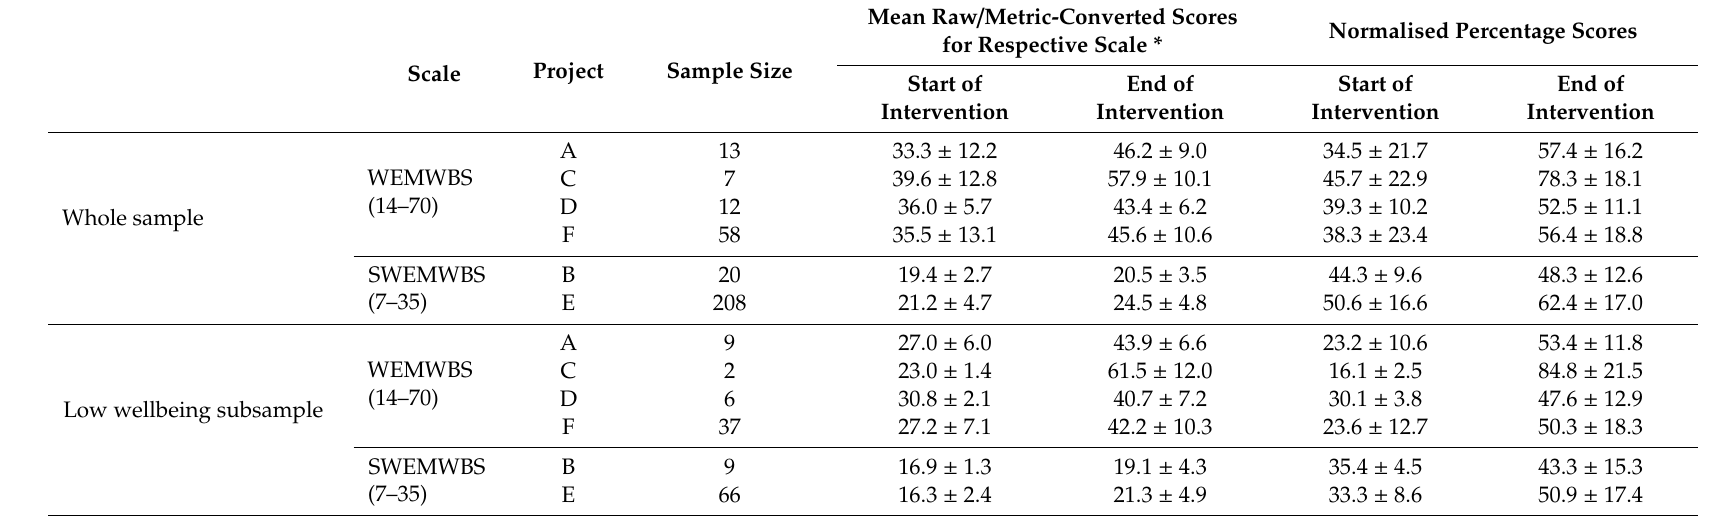
Table 1. Raw, converted and ‘normalised’ mean ± SD values by project for whole sample and low wellbeing subsample. Scale Project Sample Size